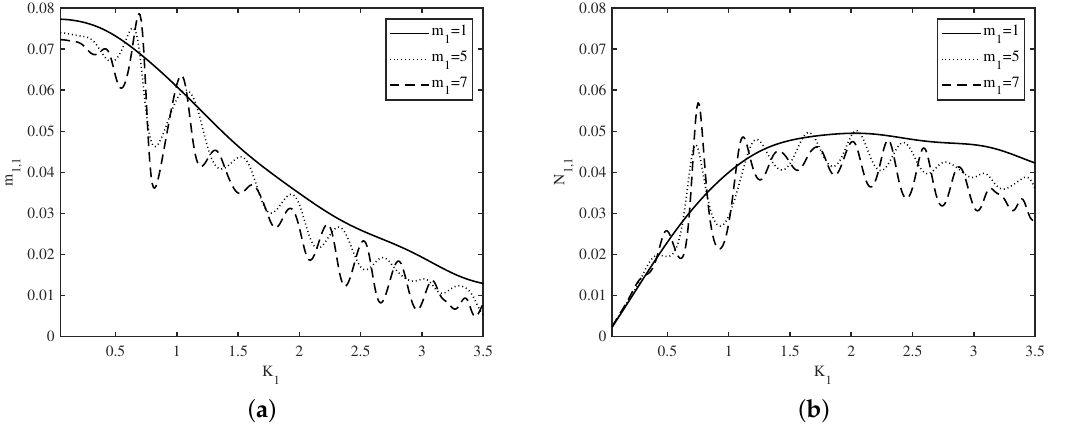
Figure 4. Variation of ( a ) m 1,1 and ( b ) N 1,1 vs K 1 for different m 1 . Figure 4 demonstrates the variation of (a) the added mass m 1,1 and (b) the damping coefficient N 1,1 as a function of non-dimensional frequency parameter K 1 for various values of number of ripples m 1 of the sinusoidally varying bottom. The overall pattern of the added mass m 1,1 and damping coefficient N 1,1 as a function of wavenumber K 1 are similar in nature as that of Figure 3. Further, it is seen that the oscillatory pattern in the added mass m 1,1 and damping coefficient N 1,1 increases with an increase in the number of ripples m 1 of the